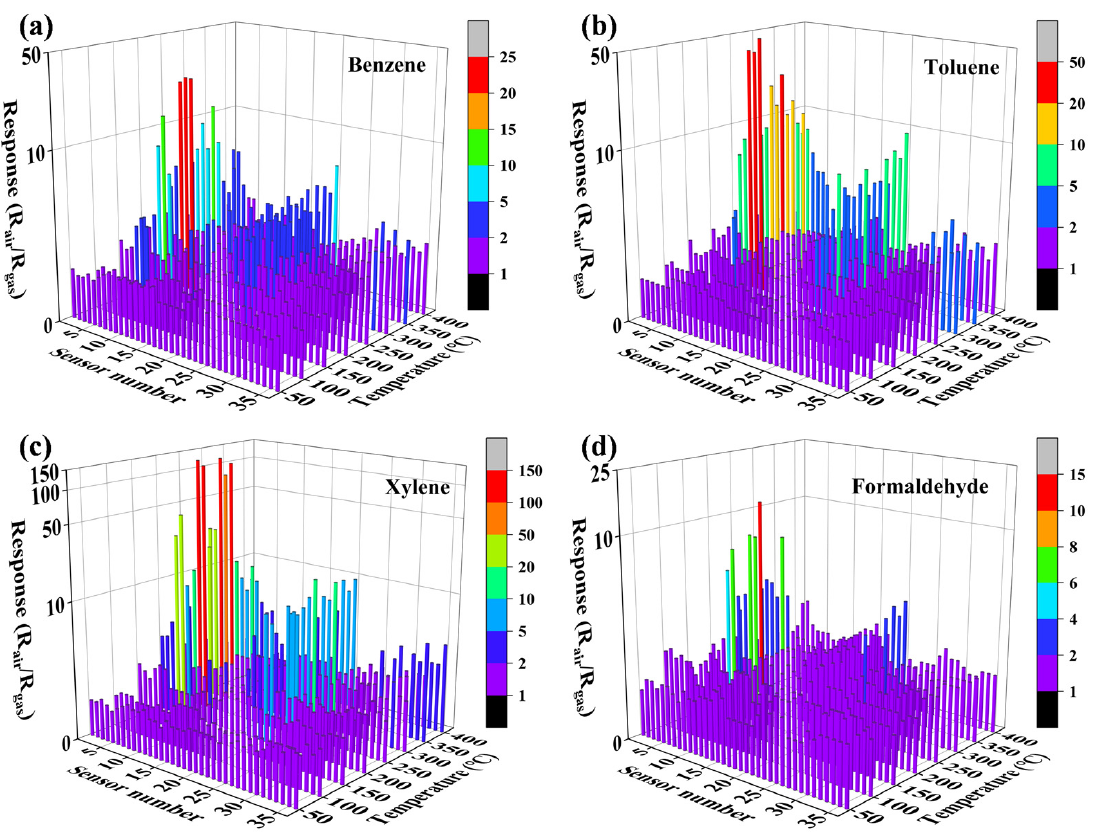
Figure 7. Responses ( R air / R gas ) of all sensors to 100 ppm of four gases at various temperatures: ( a ) benzene, ( b ) toluene, ( c ) xylene, and ( d ) formaldehyde.